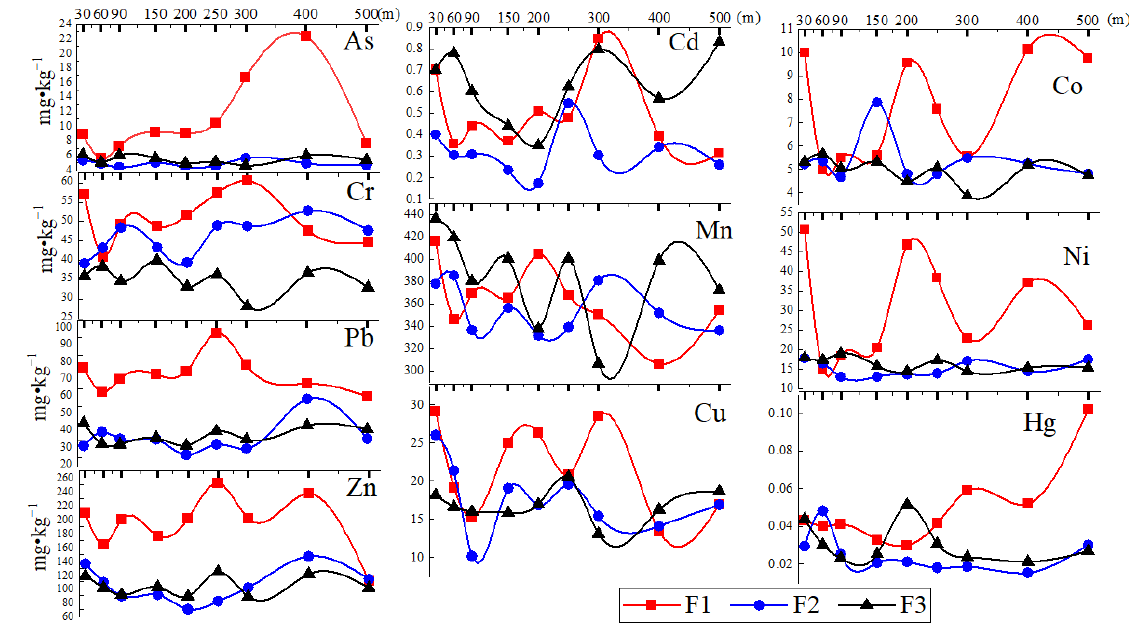
Figure 3. Dust heavy metal concentrations around the three